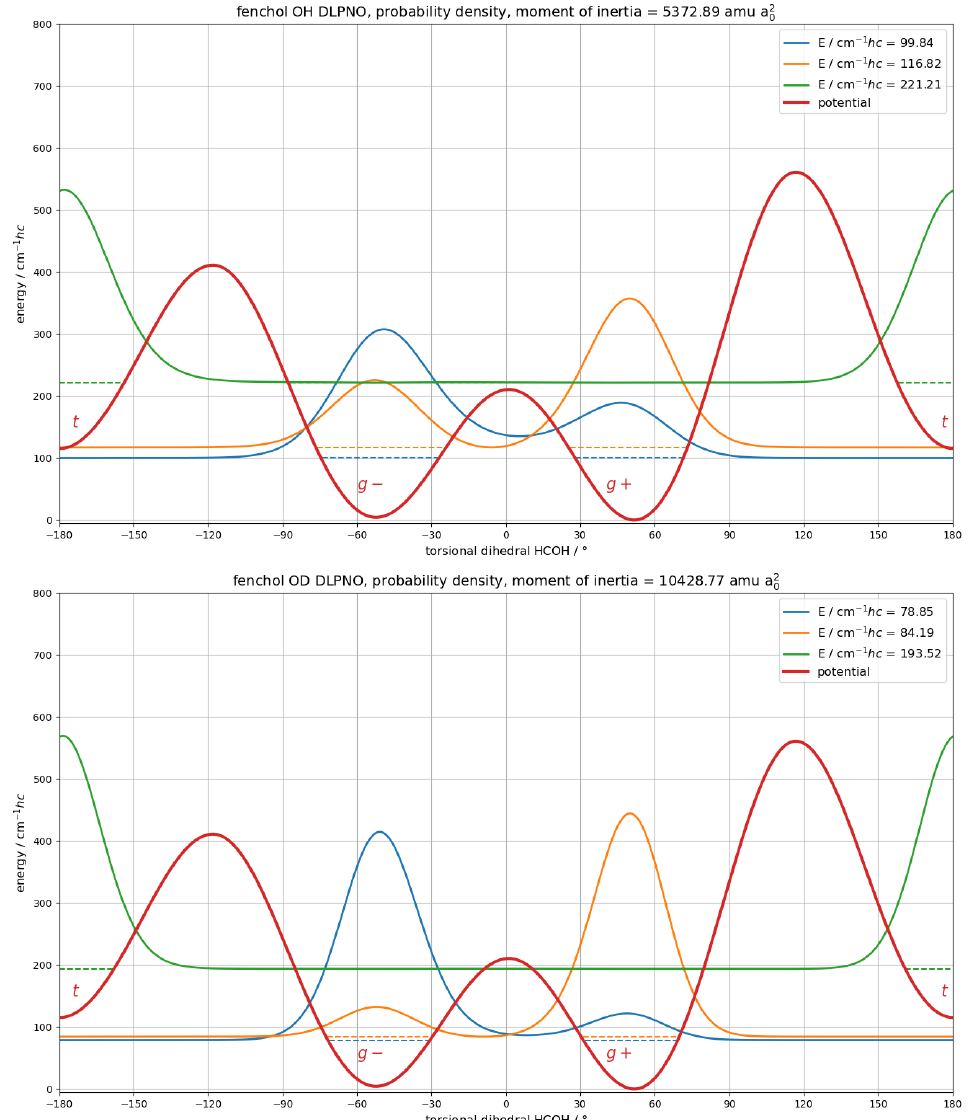
Figure 10. Electronic torsional potential (red trace) of ( + )- α -fenchol calculated at B3LYP-D3(BJ)/may- cc-pVTZ level and scaled to DLPNO-CCSD(T)/aug-cc-pVQZ single-point corrections for the six stationary points. A constant moment of inertia, as calculated for the g − minimum geometry, was used. For the protiated (top) and the deuterated alcohol (bottom), the two lowest torsional states (blue and orange horizontal dashed traces) are separated by 17.0 (OH) and 5.3 cm − 1 hc (OD) and their probability densities (blue and orange solid traces) are strongly (OH: 69%/31%) to moderately (OD: 88%/12%) delocalized between the g − / g + potential wells. In contrast, for the third torsional state, the probability density (green solid trace) is very strongly localized (>99%) in the t potential